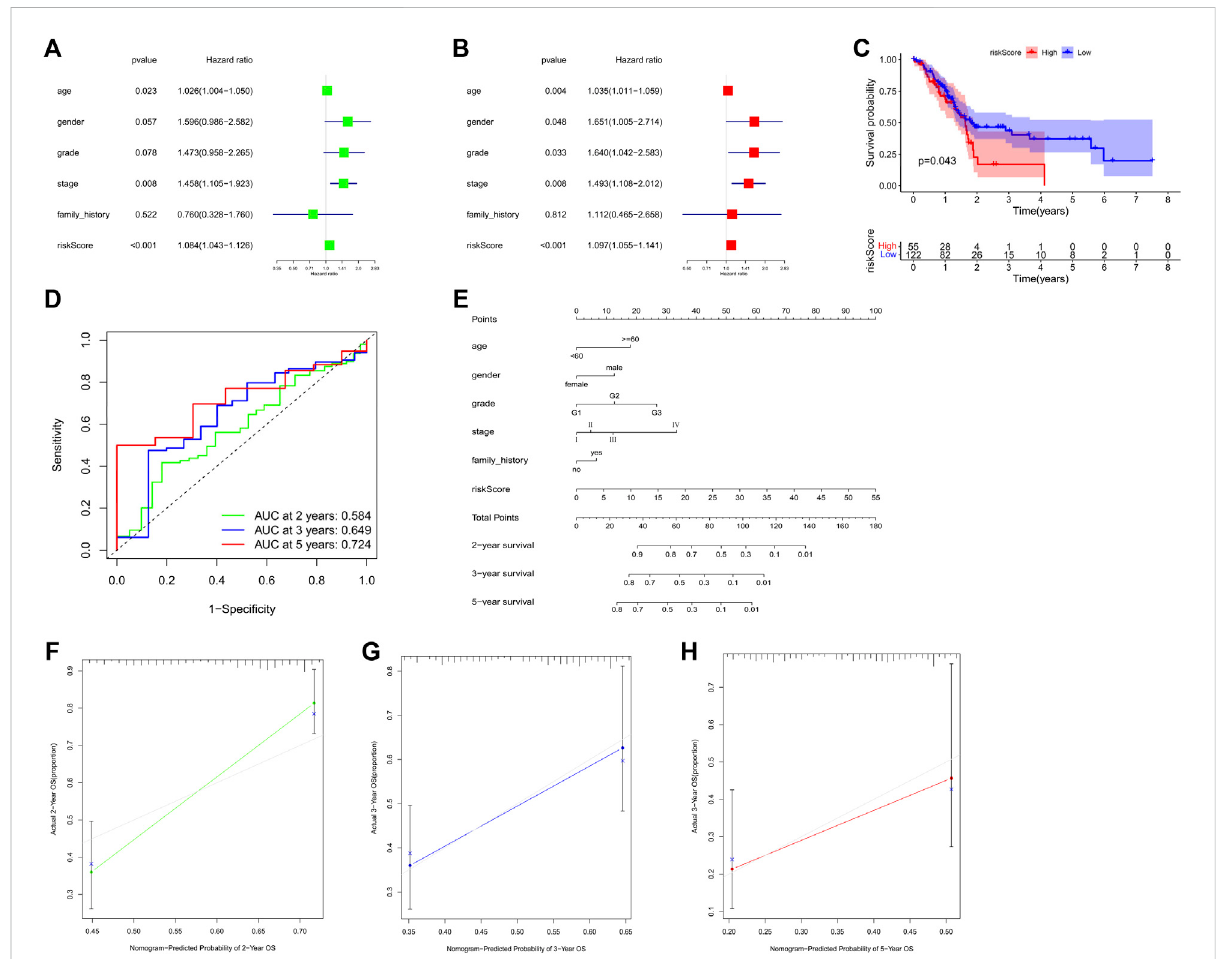
FIGURE 4 (A,B) Forestplotfortheunivariate (A) andmultivariate (B) ModeloftheriskscorealongwithclinicopathologicalvariablesonthebasisoftheCox proportional hazard regression. Kaplan-Meier curve (C) and the receiver operating characteristic (ROC) curve (D) of the relationship between risk score and OS of PANC patients. (E) Nomogram for prognosis in subjects with GC based on risk score along with the clinical data. (F – H) The nomogram ’ s calibration curve. Perfect prediction is represented by a dashed line at 45 ° . GC, gastric cancer; PANC, pancreatic cancer; OS, overall survival. * p < 0.05; ** p < 0.01; *** p <